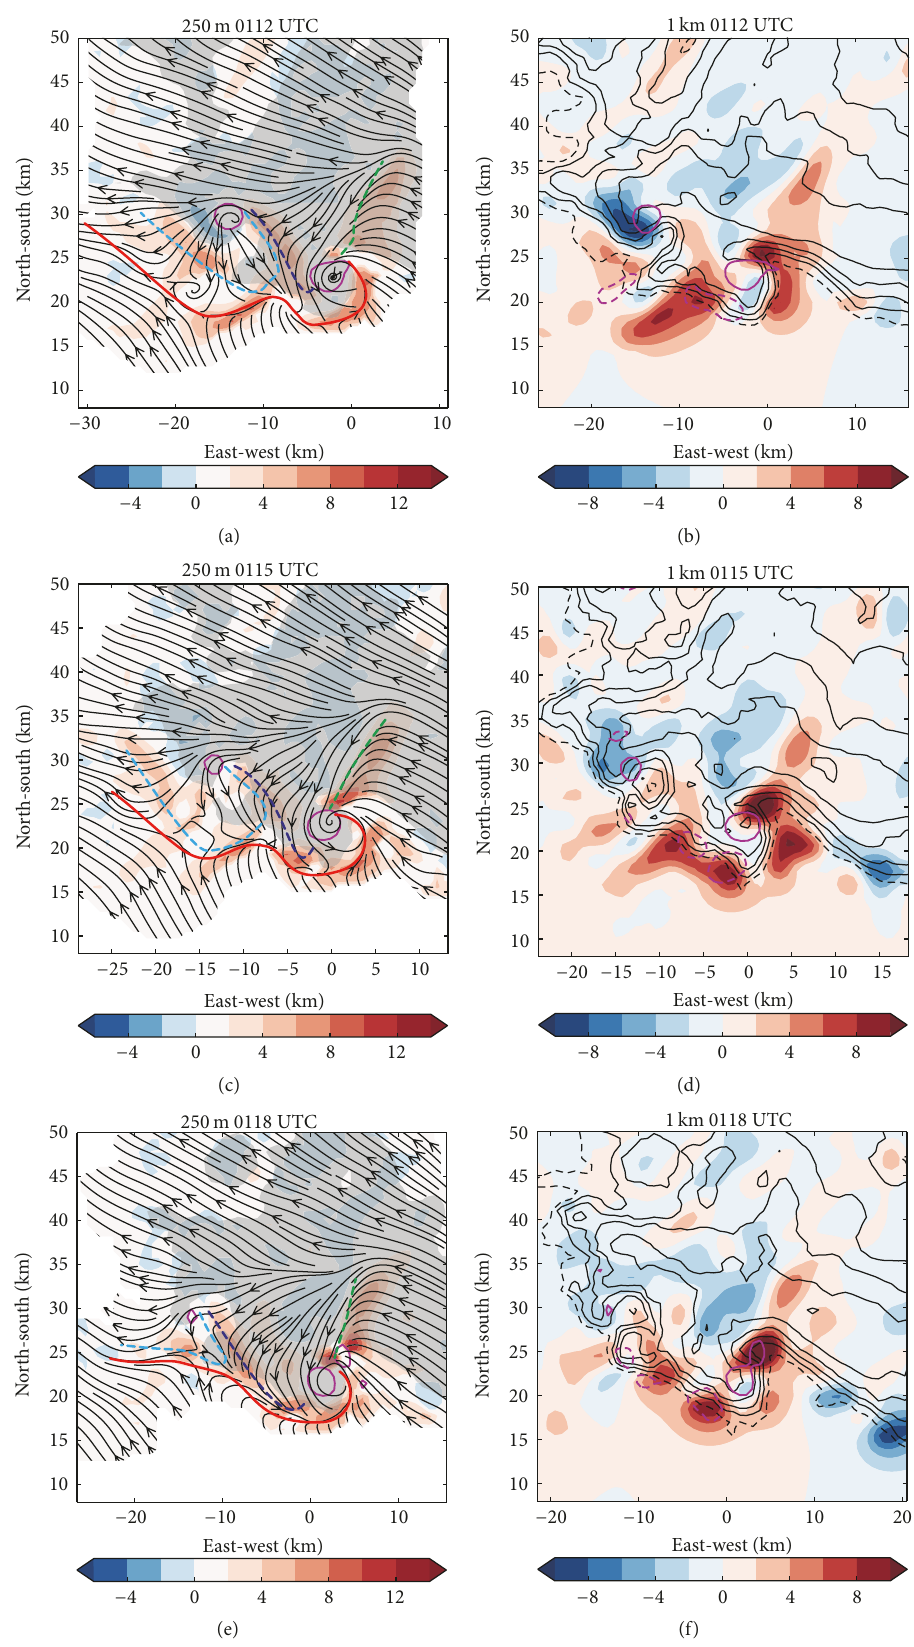
Figure 12: Same as Figure 3, except for during the organizing stage of the third